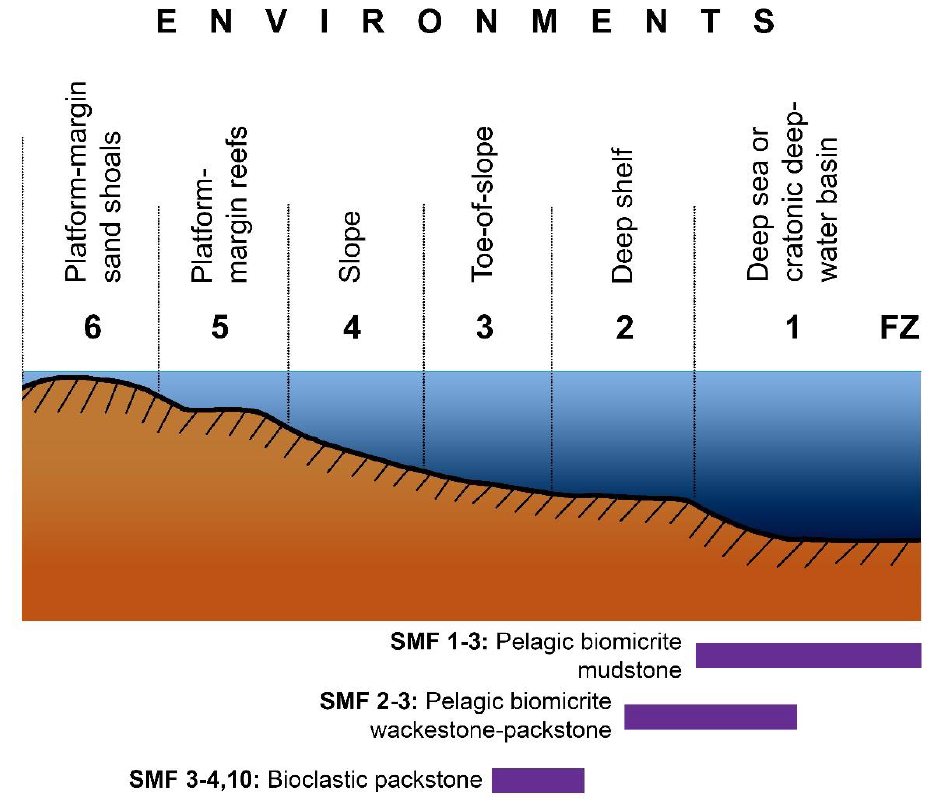
Figure 9. Depositional distribution model for Gardiki section based on microfacies analysis.